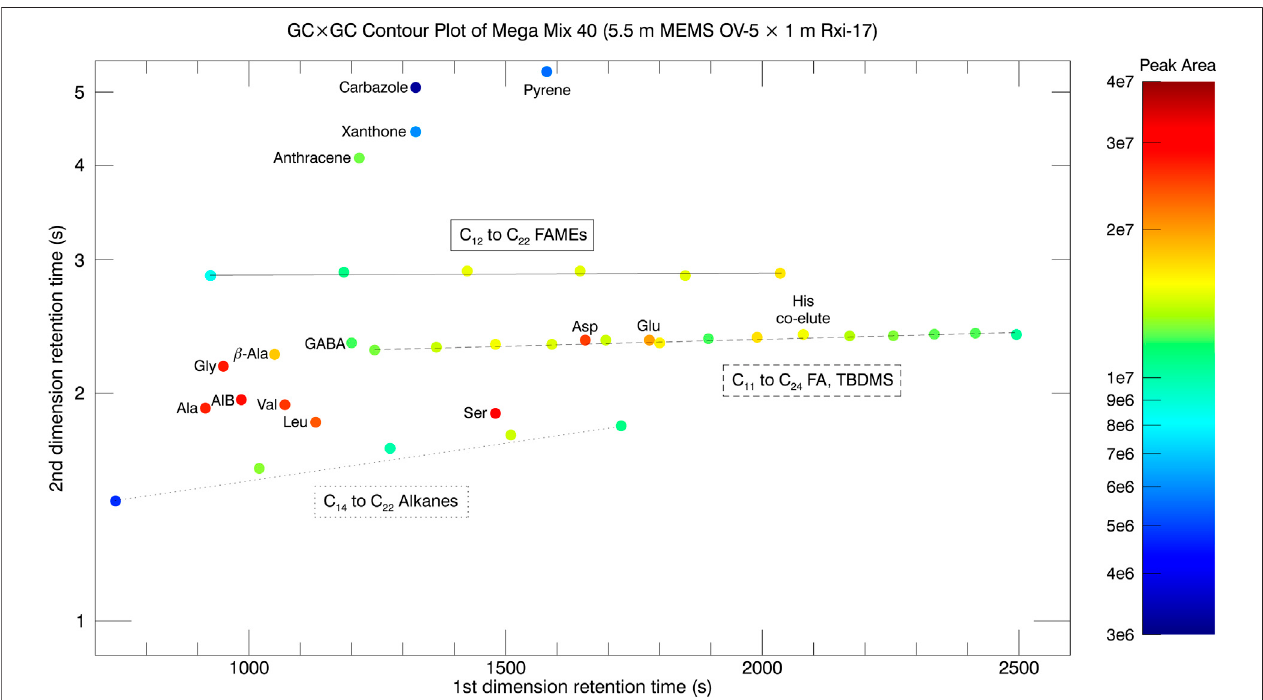
FIGURE 9 | GC × GC contour plot of Mega Mix 40 with the 5.5 m MEMS GC column as the fi rst dimension column.